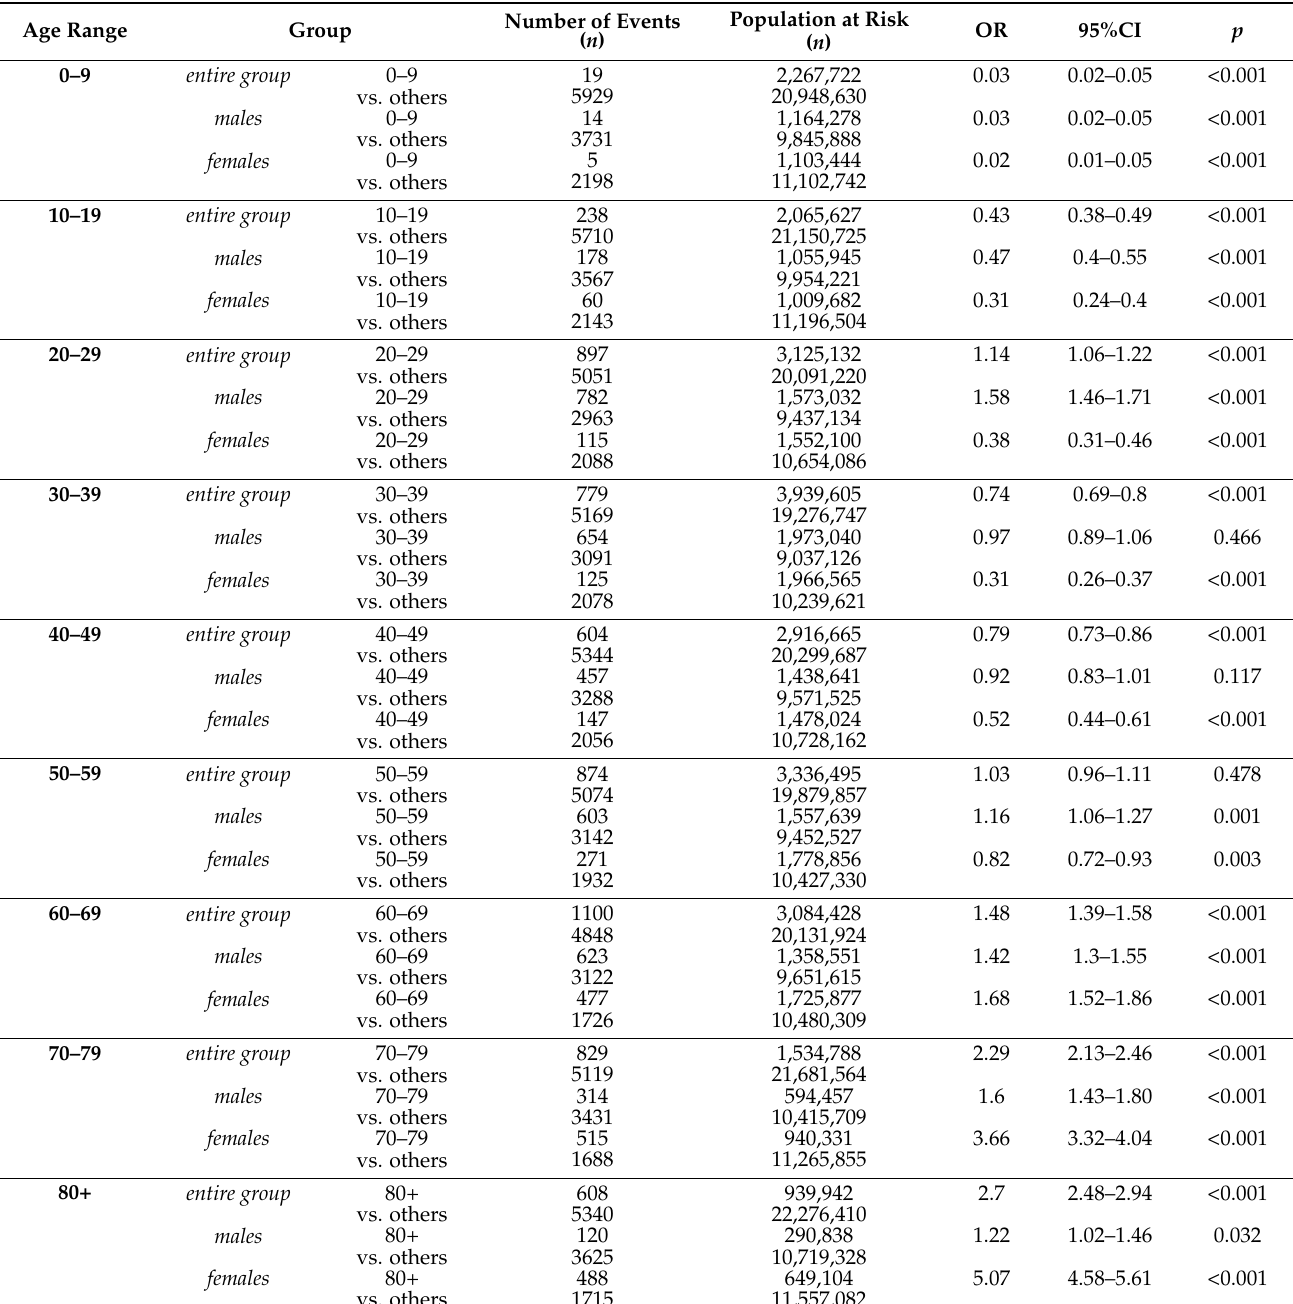
Table 2. Odds ratios (OR) for the first shoulder dislocation event in residents living in urban